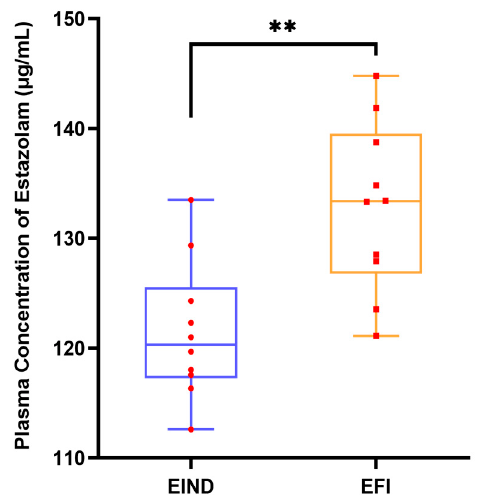
Figure 1. Plasma concentration of estazolam in mice from EFI and EIND groups at 6 × LD50 dose (500 mg/100 g). Notes: Quantitative results of plasma concentration of estazolam, n animal = 10, respectively, female: male = 1:1, **, p < 0.01, are compared between EFI and EIND groups. Statistical significance was determined with the student’s t -test. Box plots are expressed as medians (horizontal lines in boxes), 25 to 75 percentile (boxes), and extent of data (whiskers), with red circles and red squares representing specific data points. Abbreviations: EFI: Estazolam fatal intoxication, EIND: Estazolam intoxication not-dead, and EFI: Estazolam acute intoxication death. EIND meant acute intoxication over 8 h, followed by cervical dislocation. The dose and duration of administration were the same for both